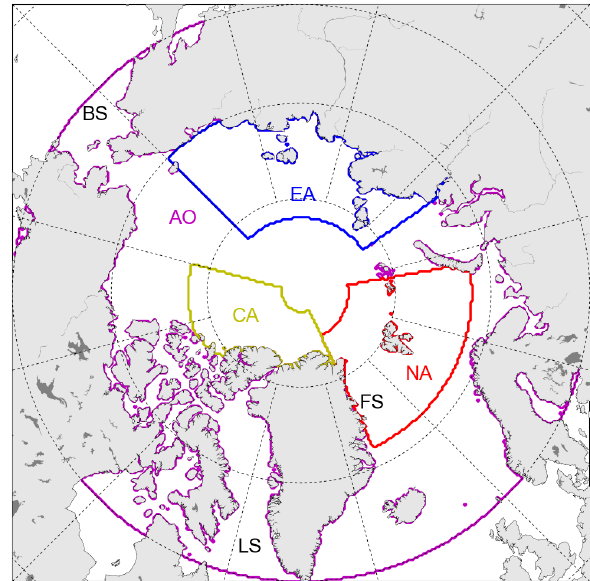
Figure 5. Map of the Arctic model domain and regions used in this study: AO: Arctic Ocean, CA: central Arctic, EA: eastern Arctic, NA: North Atlantic; BS: Bering Sea, LS: Labrador Sea (peripheral seas also discussed in the